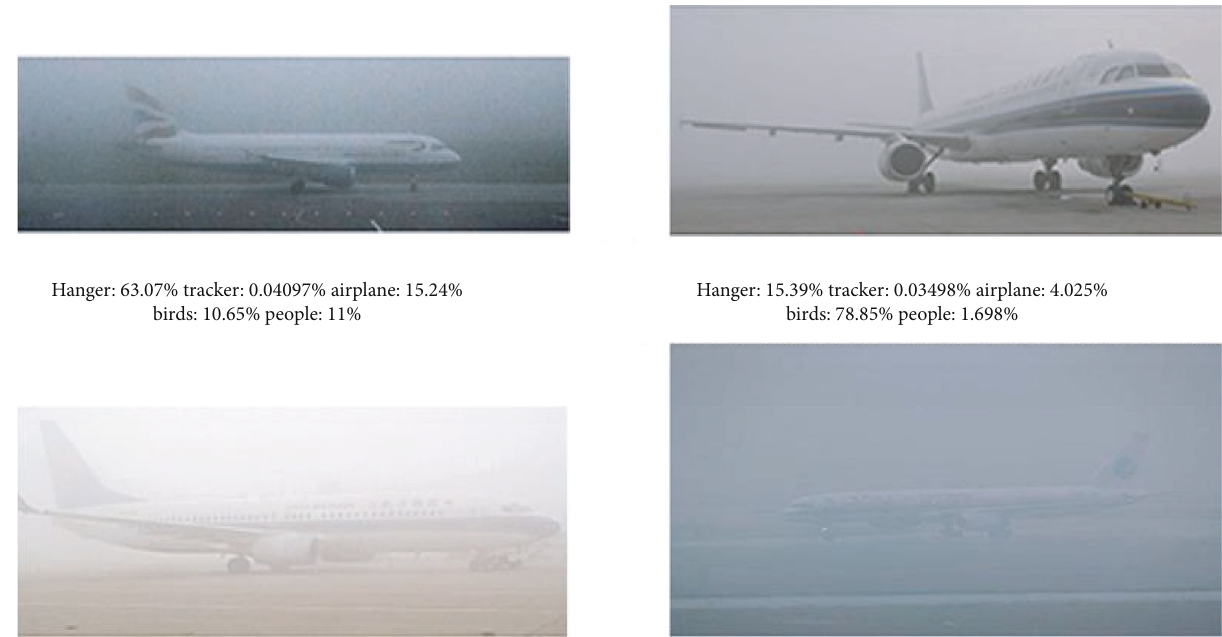
Figure 2: Low-visibility image target recognition e ff ect